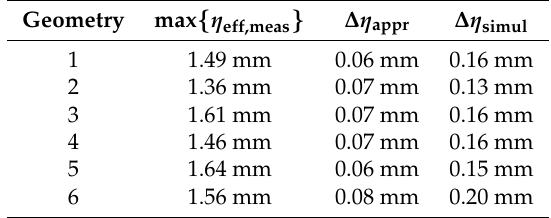
Figure 12. Exemplarily evaluated mean differences between line approximation and simulation in comparison to the measured edge for applying the quintic polynomial motion profile that was not used for model parameter identification. Table 5. Summary of the evaluated effective fluid edge measures for all investigated geometries and their corresponding differences from approximation and model